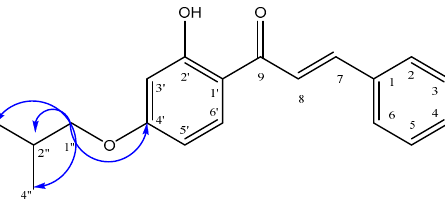
Figure 1. Most important correlations 2D 1 H– 13 C HMBC, compound 4 .